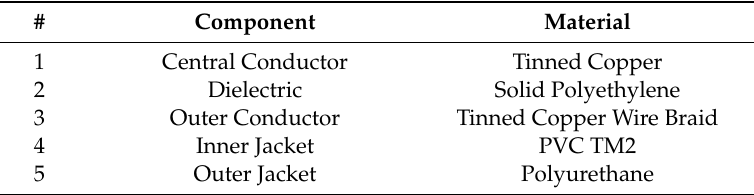
Figure 3. Cross-section of marinized RG58 cable. Table 2. Component and material description of marinized RG58 cable.